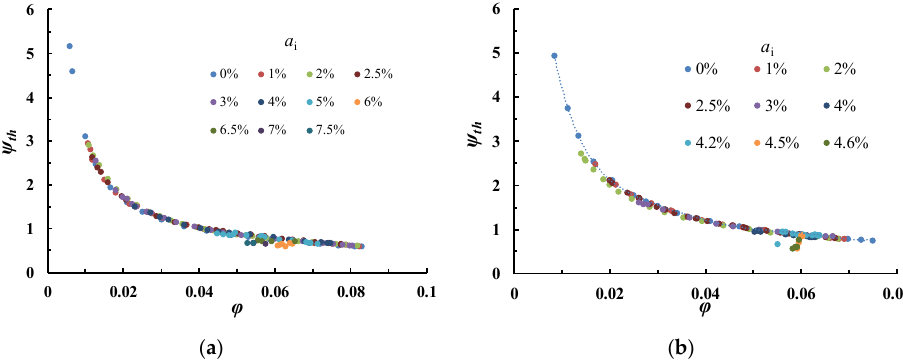
Figure 5. Pump theoretical head coefficients for two rotational speed: ( a ) n = 1450 r/min and ( b ) n = 1000 r/min.